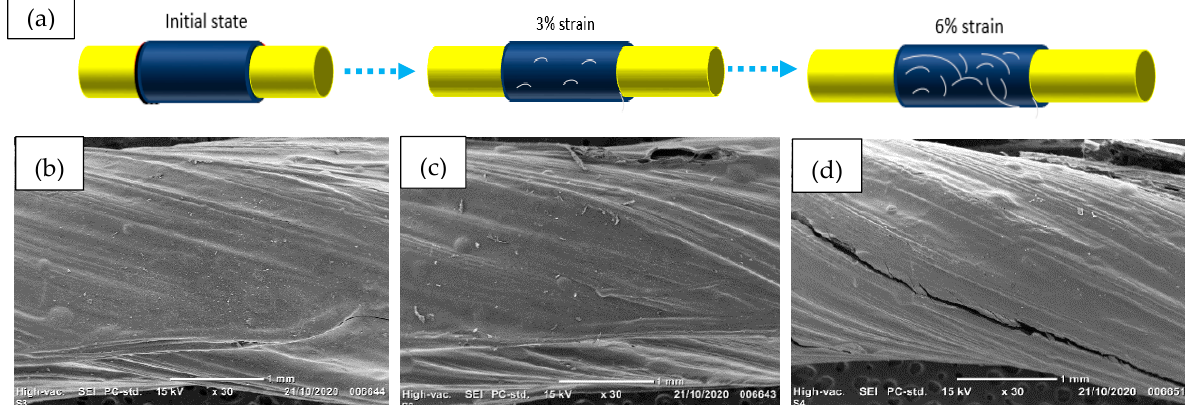
Figure 6. ( a ) morphological modifications of sensor yarns with four coated layers of PEDOT:PSS at different strain levels. SEM images of sensor yarns ( b ) without applied strain, ( c ) applied strain at 3% and ( d ) applied strain at 6%.